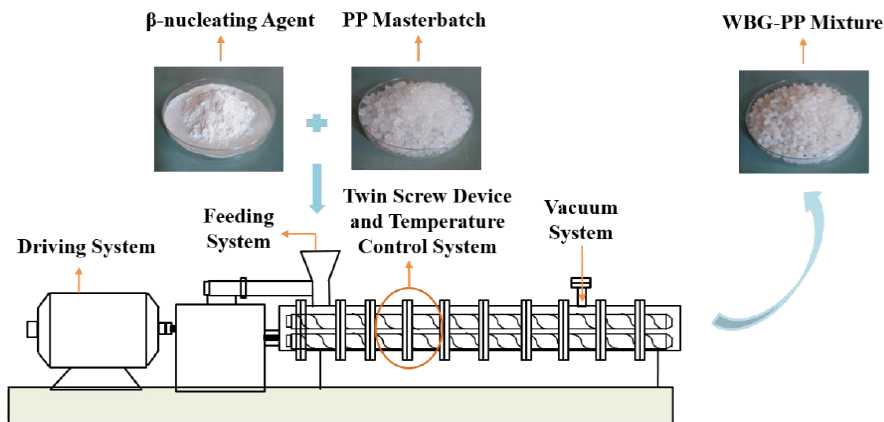
Figure 1. Process flow chart of preparing β -nucleating agent polypropylene (WBG-PP) using a twin-screw extruder.